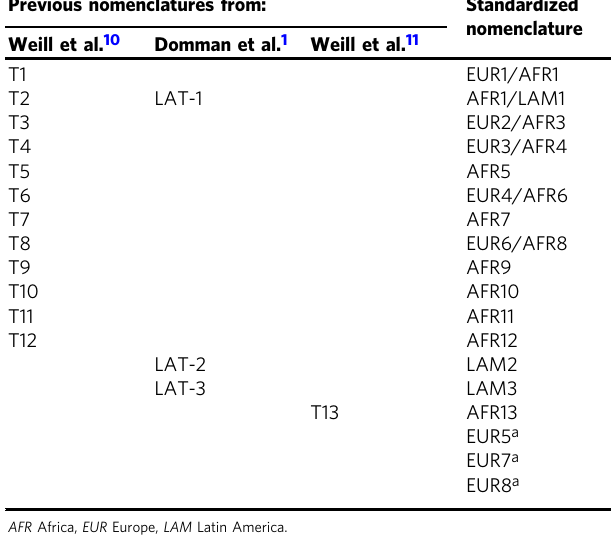
Table 2 Standardized nomenclature of the seventh pandemic Vibrio cholerae El Tor sublineages introduced into Europe, Africa, and